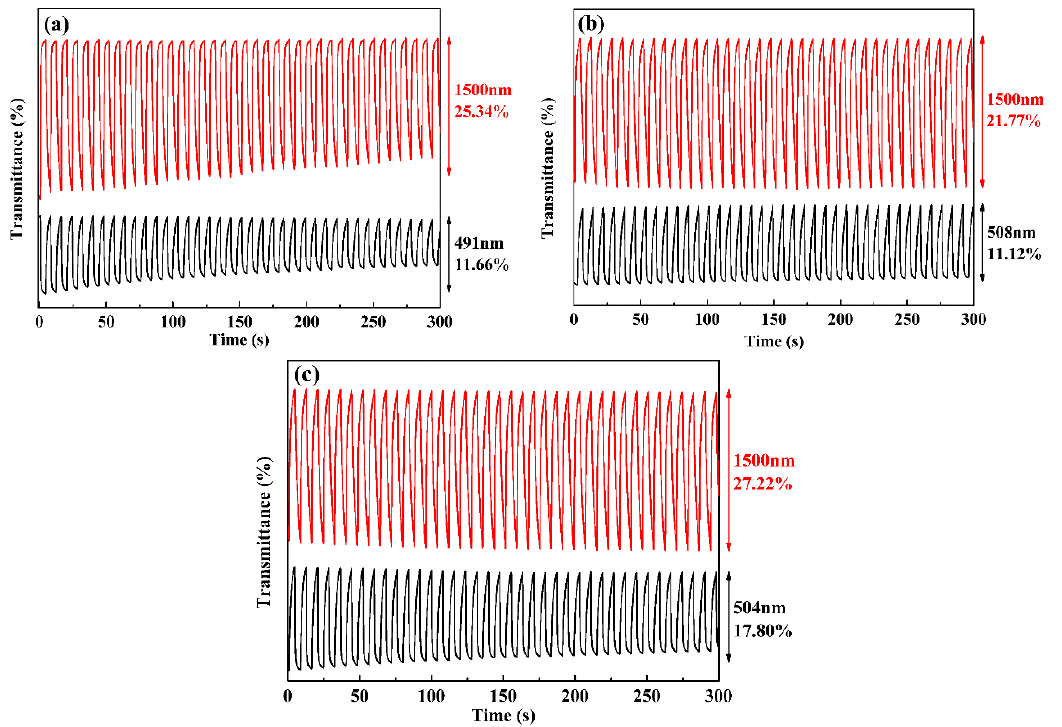
Figure 7. Square-wave potential step absorptiometry of PBPE-1 ( a ), PBPE-2 ( b ) and PBPE-3 ( c ) films monitored at various wavelengths in the visible and near-infrared regions. Table 2. Optical contrasts (∆T%), coloration efficiencies (CE) and response times (t 95% ) of PBPE-1, PBPE-2 and PBPE-3.